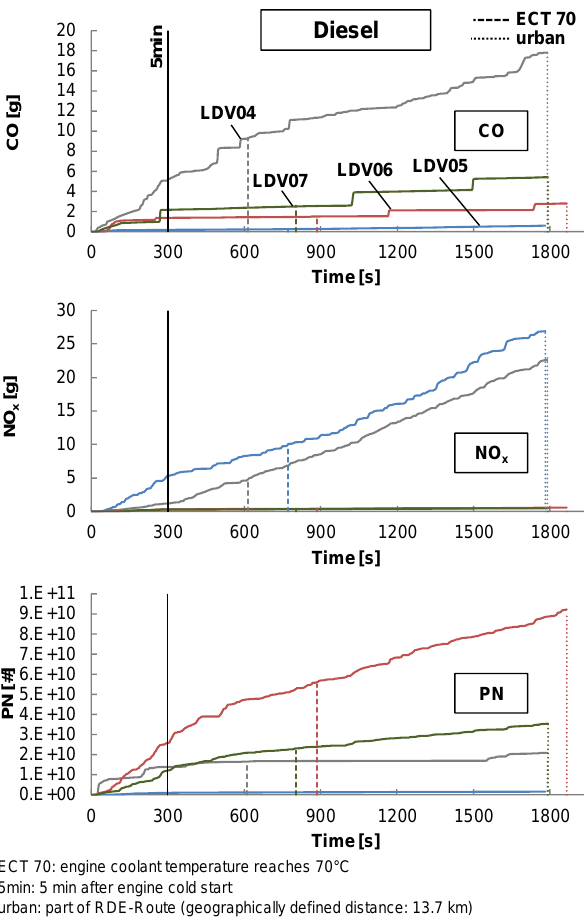
Fig. 8. Cumulated emissions of Diesel vehicles during the warm-up phase The NO [g/km] values of two Diesel vehicles (LDV4 Fig. 7. Cumulated emissions of gasoline vehicles during the warm-up x phase & LDV5) are very high, which particularly signalizes a misfunction of the SCR-system of LDV5 (LDV4 is not From the comparison of vehicles, it can be stated, that: equipped with SCR). The specific emissions in warm-up  vehicles with smaller engine displacement produce are sometimes higher than in the urban phase with the “in- lower CO -emissions, crease factor” ranging between 0.9 & 7.5 for gasoline and 2 0.9 & 5 for Diesel